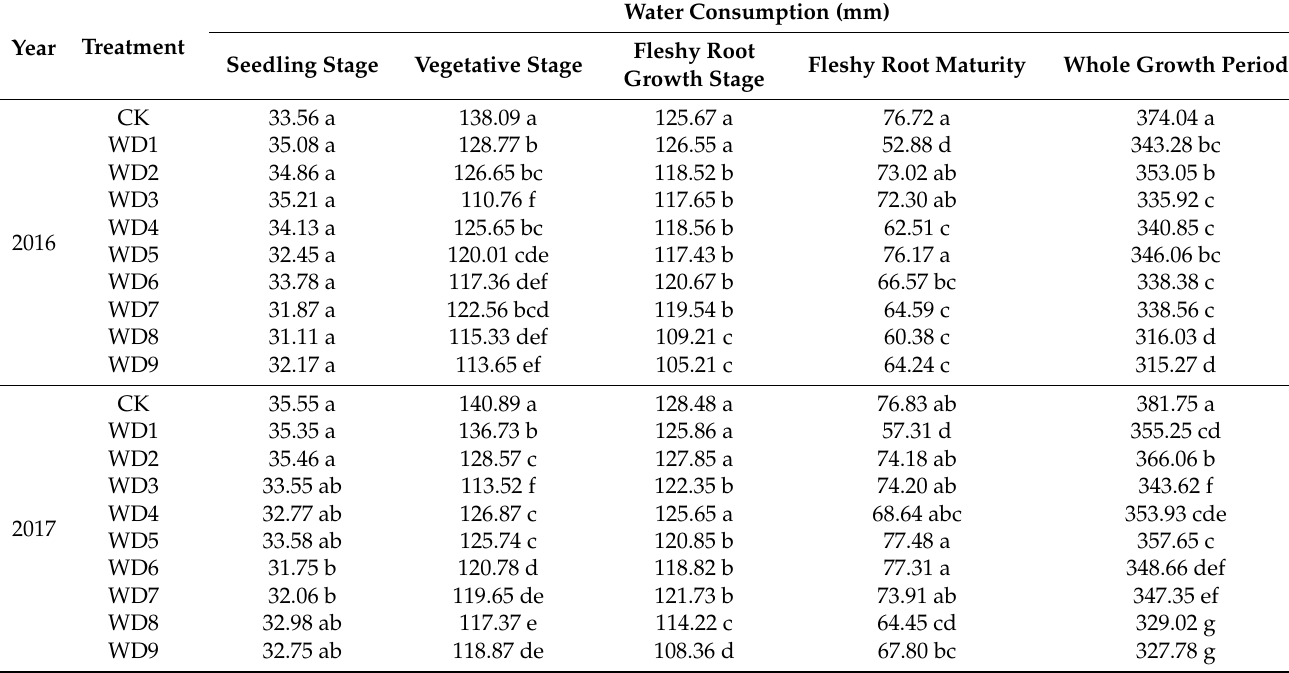
Table 2. Isatis indigotica water consumption at different growth